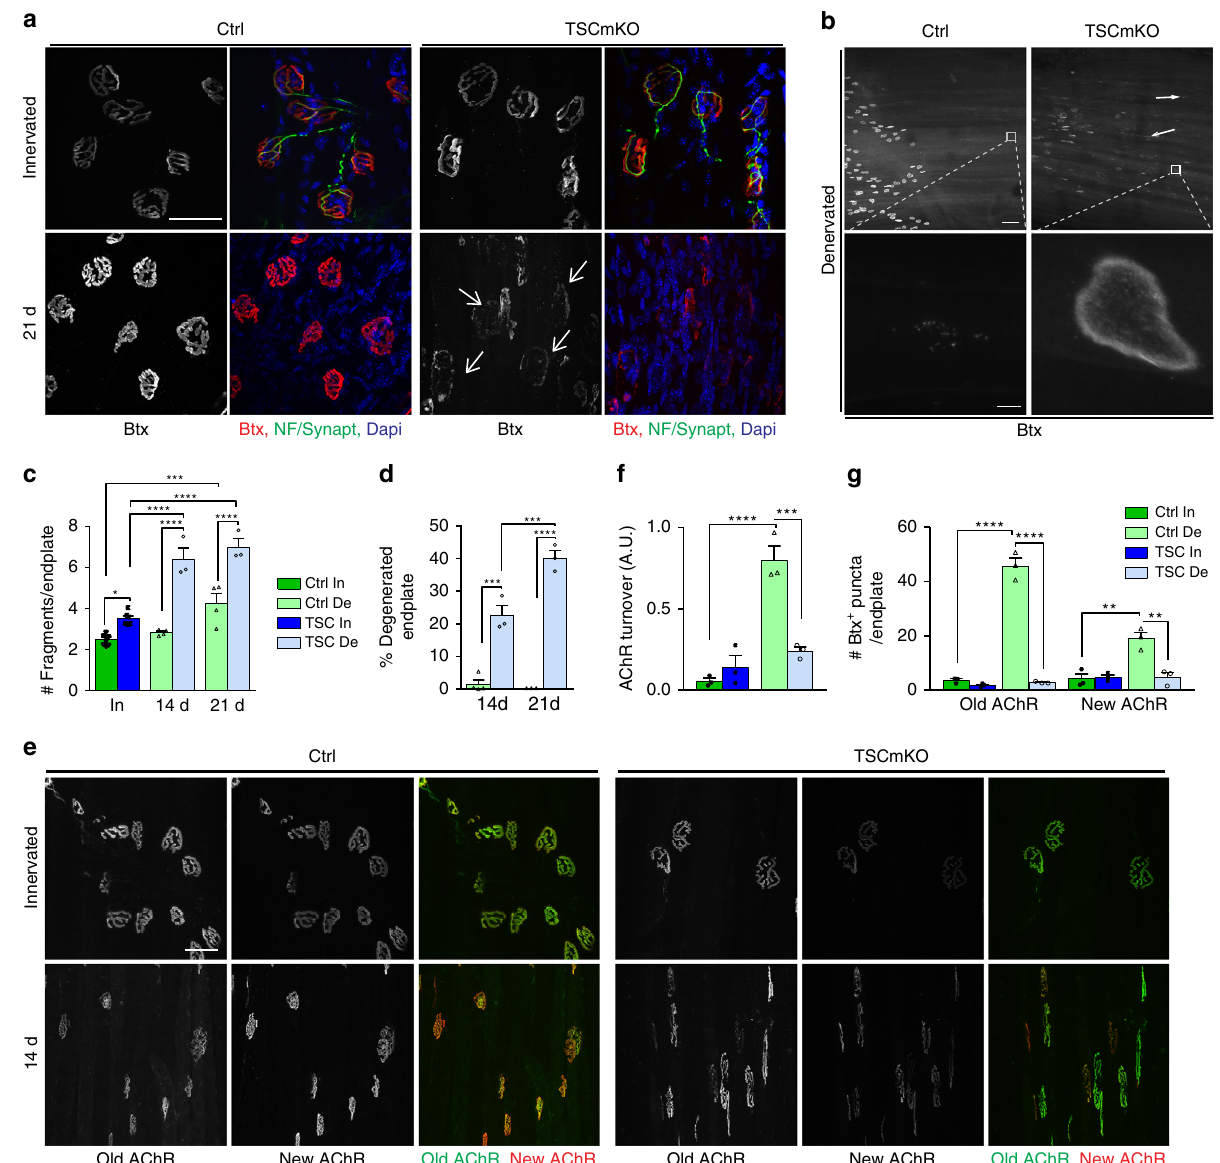
Fig. 4 Sustained mTORC1 activation alters endplate maintenance and abrogates AChR turnover. a Fluorescent images of TA innervated and denervated (21d), control (Ctrl) and TSCmKO muscles showing NMJ regions stained with α -bungarotoxin (Btx, red) and antibodies against neuro fi lament and synaptophysin (NF/Synapt, green). Representative of 6 independent muscles per group. Arrows point to degenerated endplates. Scale bar, 50 µ m. b Fluorescent images of TA denervated control and TSCmKO muscles stained with α -bungarotoxin (Btx). High magni fi cation pictures of the insets (lower panel) show ectopic plaque-like AChR clusters in TSCmKO muscle. Representative of 6 independent muscles per group. Scale bar, 100 (top) and 5 (inset) µ m. c , d Number of fragments per endplate ( c ) and proportion of degenerated endplate ( d ) in TA control and TSCmKO (TSC) muscles after 14 and 21 days of denervation (De). c , n = 8 (In) and 4 (De) Ctrl, 6 (In) and 3 (De) TSCmKO muscles; d , n = 4 (Ctrl, 14d) and 3 (all other groups) independent muscles. e Fluorescent images of “ old ” (green) and “ new ” (red) AChRs in control and TSCmKO muscles (6 TA and 3 EDL muscles per genotype) in innervated muscle and after 2 weeks of denervation. Scale bar, 50 µ m. f , g Quanti fi cation of AChR turnover ( f , EDL muscle) and of endocytosed vesicles containing old or new AChRs ( g ) in innervated (In) and denervated (De) muscles from control and TSCmKO mice. n = 3 muscles per group. All values are mean ± s.e.m.; two-way ANOVA with Tukey ’ s post-hoc test, * p < 0.05, ** p < 0.01, *** p < 0.001, **** p < 0.0001. Source Data are provided in the Source Data